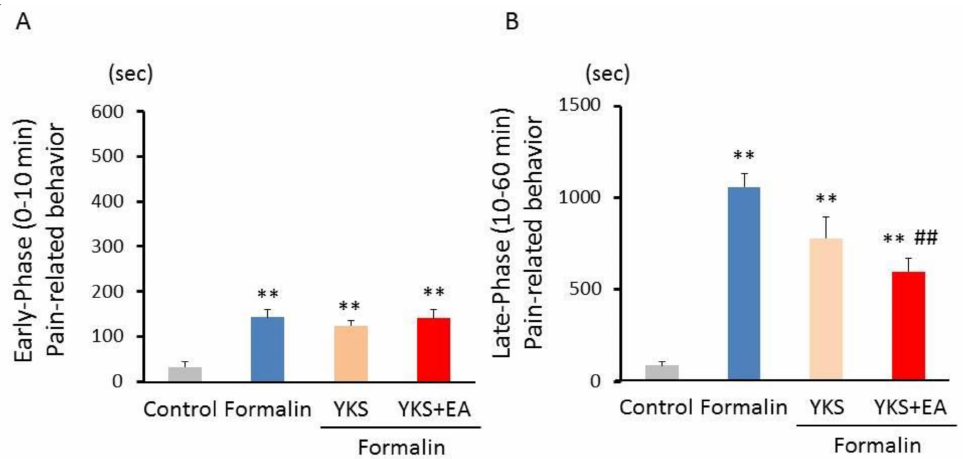
Figure 2. Preemptive analgesic effect of YKS and that of a combination of YKS and EA on pain-related behaviors induced by formalin injection. The total durations of the pain-related behaviors during the early ( A ) and late phases ( B ) are shown. The combination of YKS and EA led to significant antinociceptive effects during the late phase of the response, while YKS alone tended to show analgesic effects. n = 6; ** p < 0.01 (vs. the control group); ## p < 0.01 (vs. the formalin